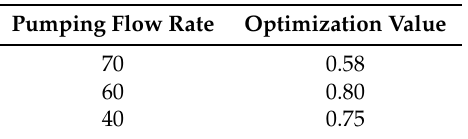
Table 2. Optimization value for sample pumping flow